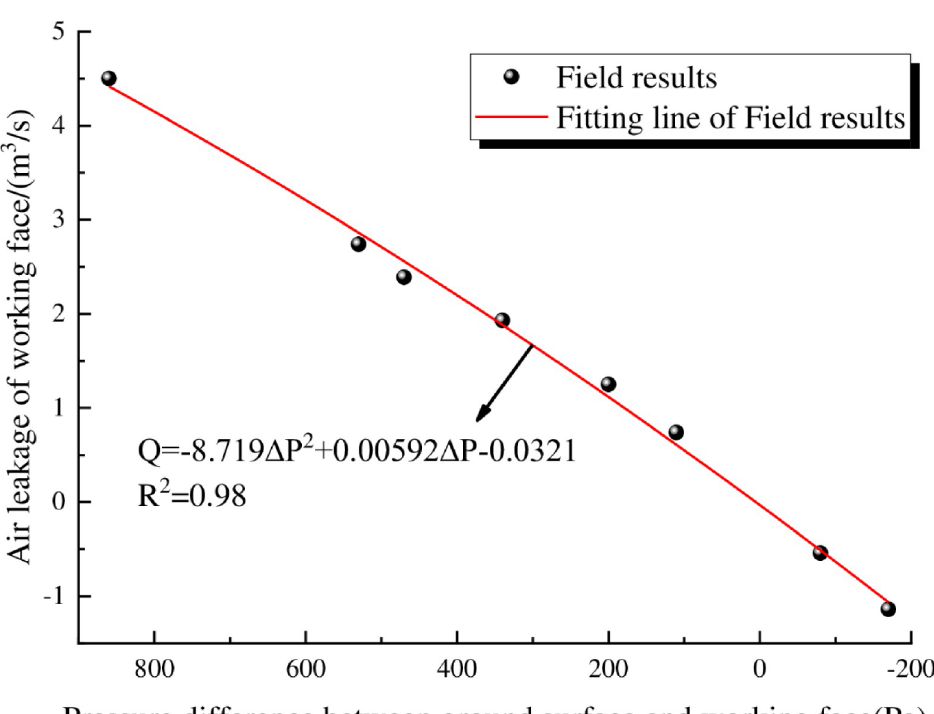
Fig 14. Prediction of air leakage in the 6104 working face.